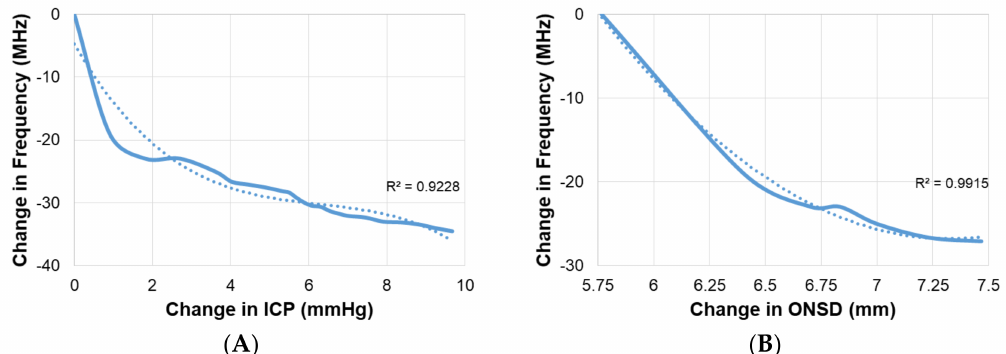
Figure 11. ( A ) Correlation between intracranial pressure (calculated using optic nerve sheath diameter) and principal resonant frequency shift; ( B ) Correlation between optic nerve sheath diameter and principal resonant frequency shift. The dotted lines are trend lines.